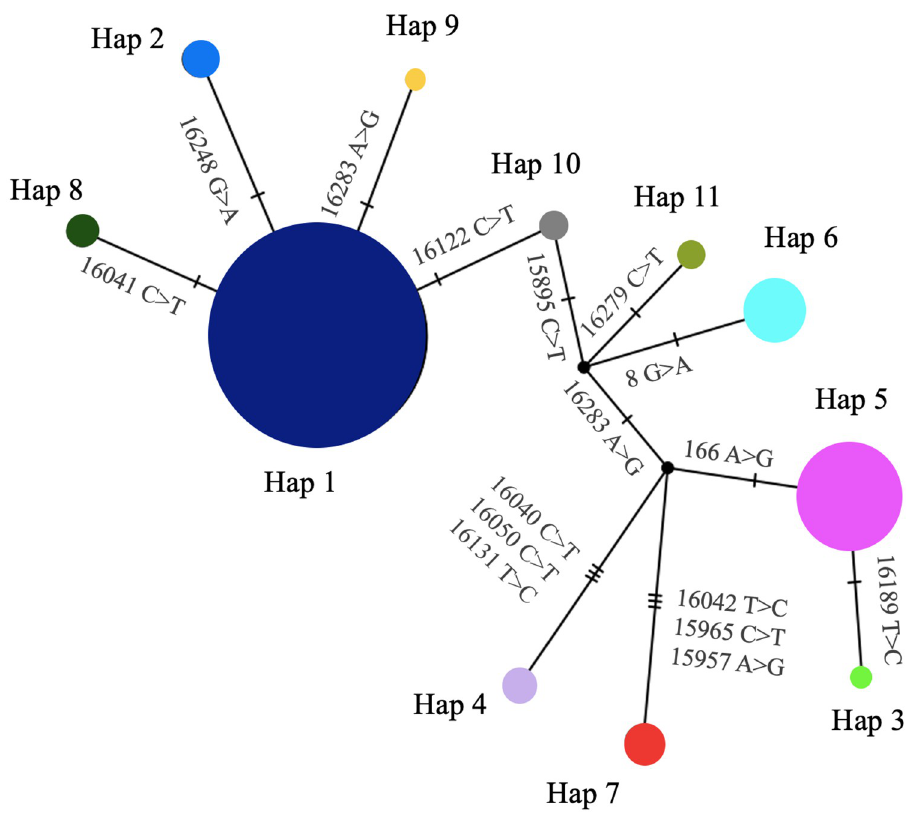
Fig 2. Median joining network tree for bison haplotypes in 14 U.S. Department of Interior and Parks Canada Agency bison herds. Circle size is proportional to haplotype frequency and hatch marks depict mutation events. Color of haplotype circles match those in Fig 1.